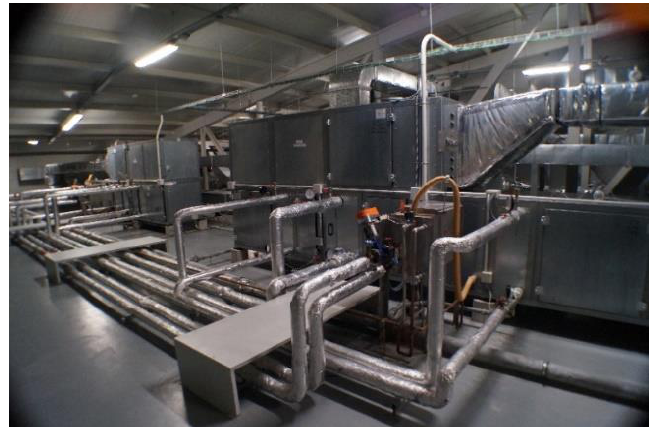
Figure 1. Heating, ventilation and air conditioning (HVAC) system of the surgical suite. In particular, Air Handling Units (AHUs) from OR2 and OR3.